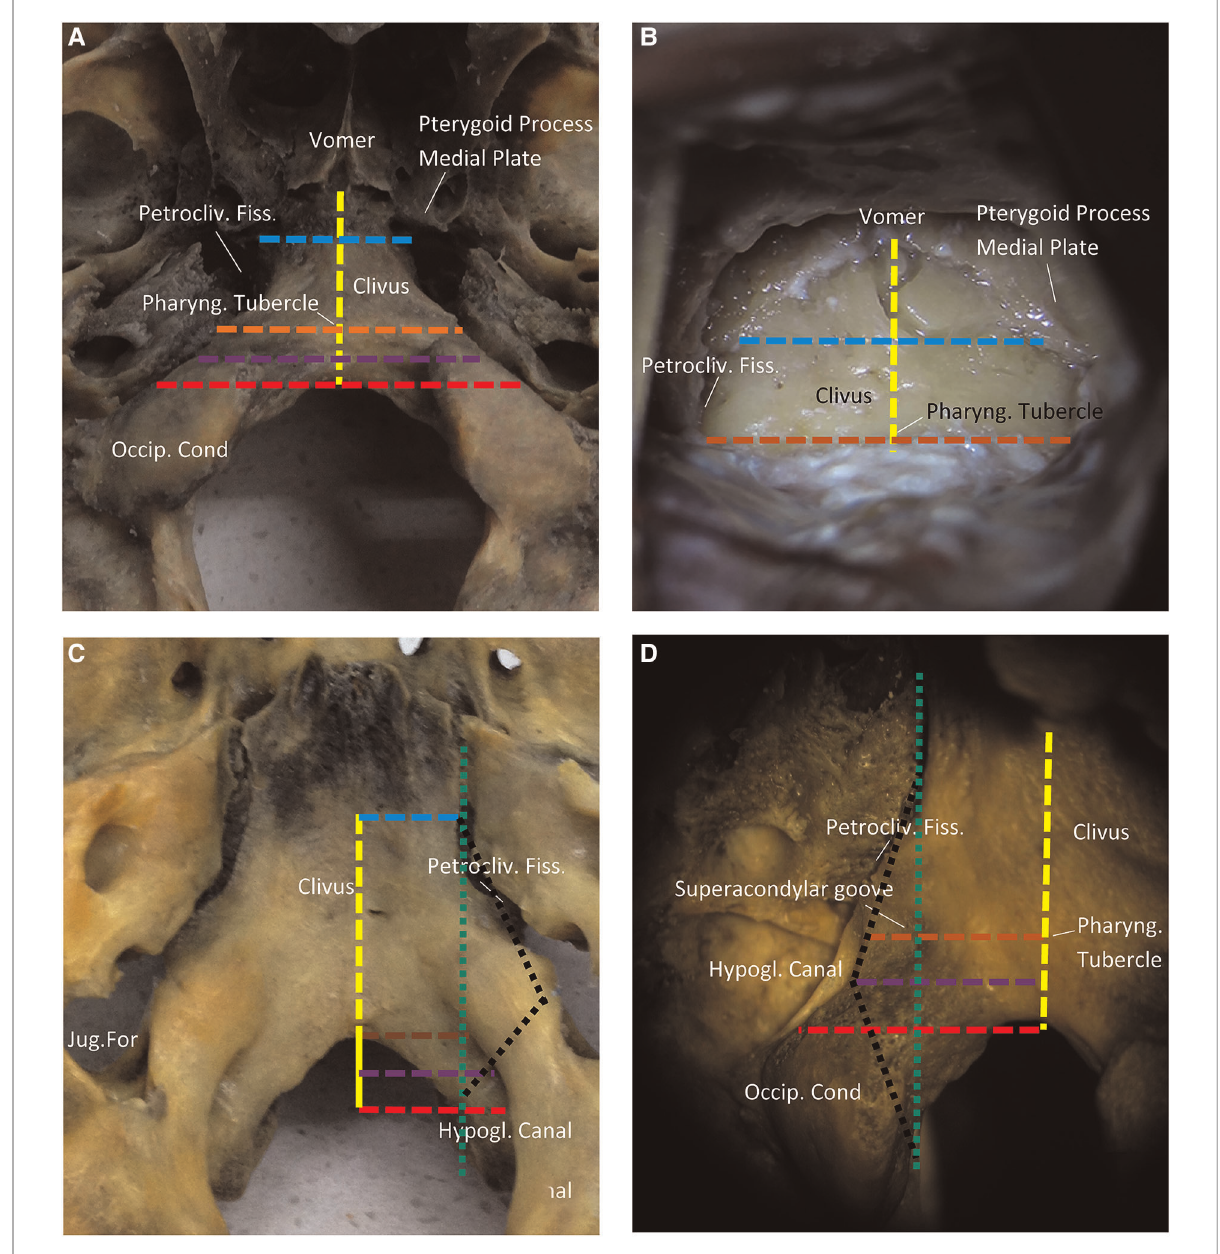
FIGURE 2 Surgical anatomy and measurements of the lower clivus and ventral foramen magnum. ( A ) The ventral side of the clivus. Occipital foramen-vomer (yellow line). The width of the clivus at the pharyngeal tubercle level (brown line). The width of clivus at the pterygoid process medial plate level (blue line). The width of clivus at the hypoglossal canal outside the hole midpoint (purple line). The width of the clivus at the inferior margin of the hypoglossal canal outside the hole (red line). ( B ) Initial exposure of the clivus. ( C ) The interior side of the clivus. The green line is the line from the petroclival fi ssure to the hypoglossal canal inside the hole. The lateral limit of the medial condylectomy is the hypoglossal canal inside the hole. ( D ) The hypoglossal canal outside the hole. It is directed backward and medially at a 45° angle with the sagittal plane. The pharyngeal tubercle is at the same level with the superior margin of hypoglossal canal outside the hole. The lateral limit of the medial condylectomy is de fi ned by the dotted black line (petroclival fi ssure to superior margin hypoglossal canal outside the hole to the hypoglossal canal inside the